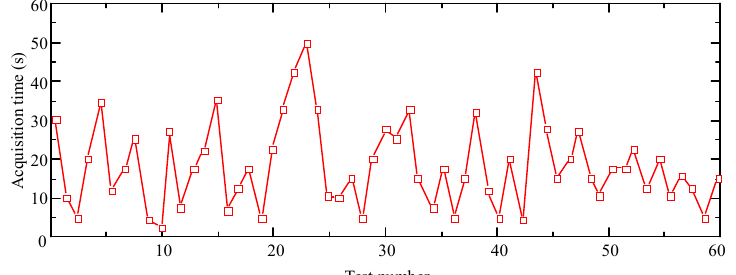
Fig. 7 Statistics of the acquisition times.